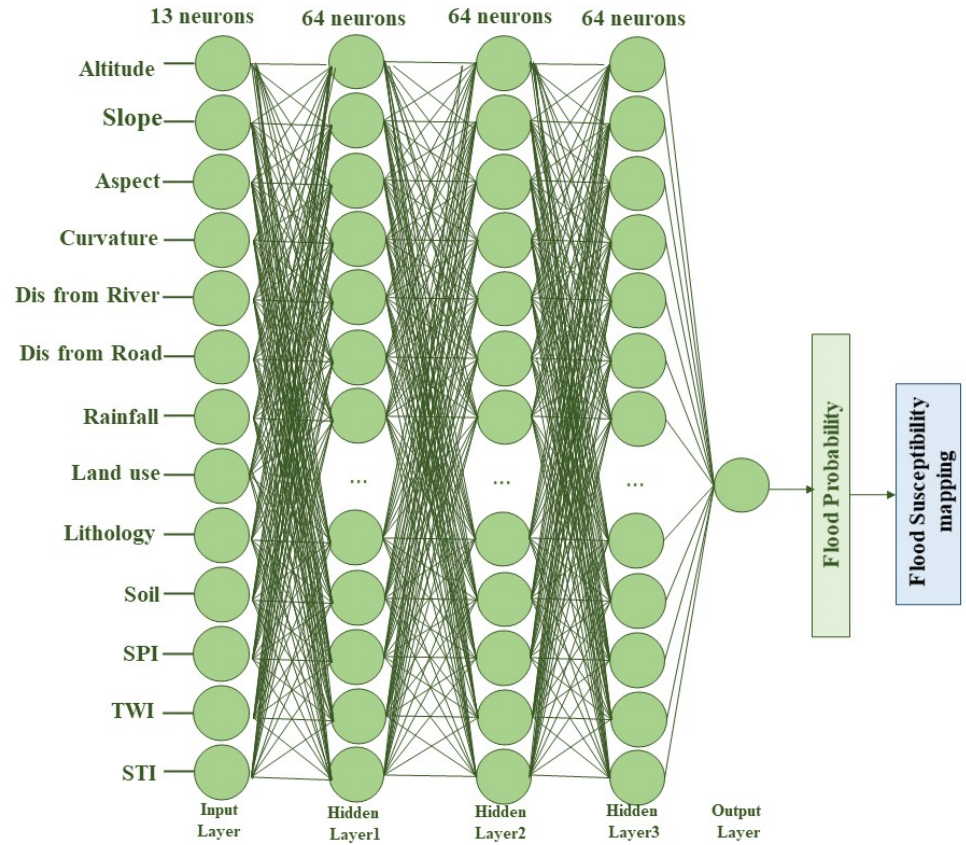
Figure 5. Simplified representation of DLNN.